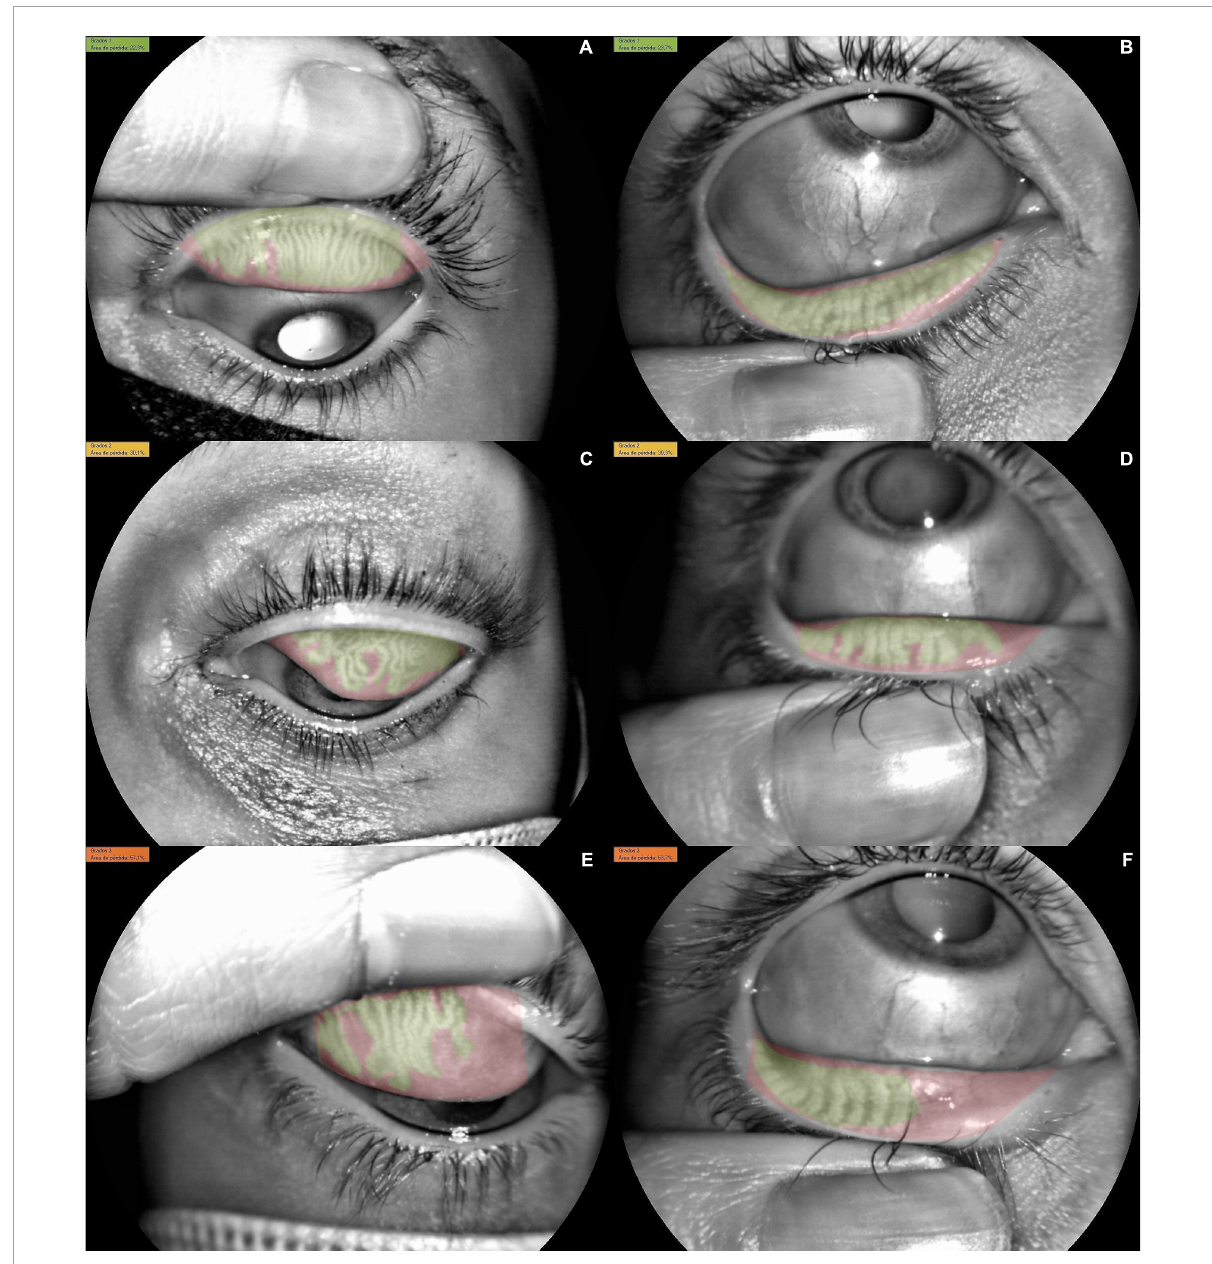
FIGURE1 Meibomian gland dysfunction (MGD) distribution among the sample. (A) Superior eye lid with Grade 1 dysfunction (22.3% of MGD), (B) inferior eye lid with Grade 1 dysfunction (23.7% of MGD), (C) superior eye lid with Grade 2 dysfunction (30.1% of MGD), (D) inferior eye lid with Grade 2 dysfunction (39.3% of MGD). (E) Superior eye lid with Grade 3 dysfunction (57.1% of MGD), (F) inferior eye lid with Grade 3 dysfunction (53.7% of